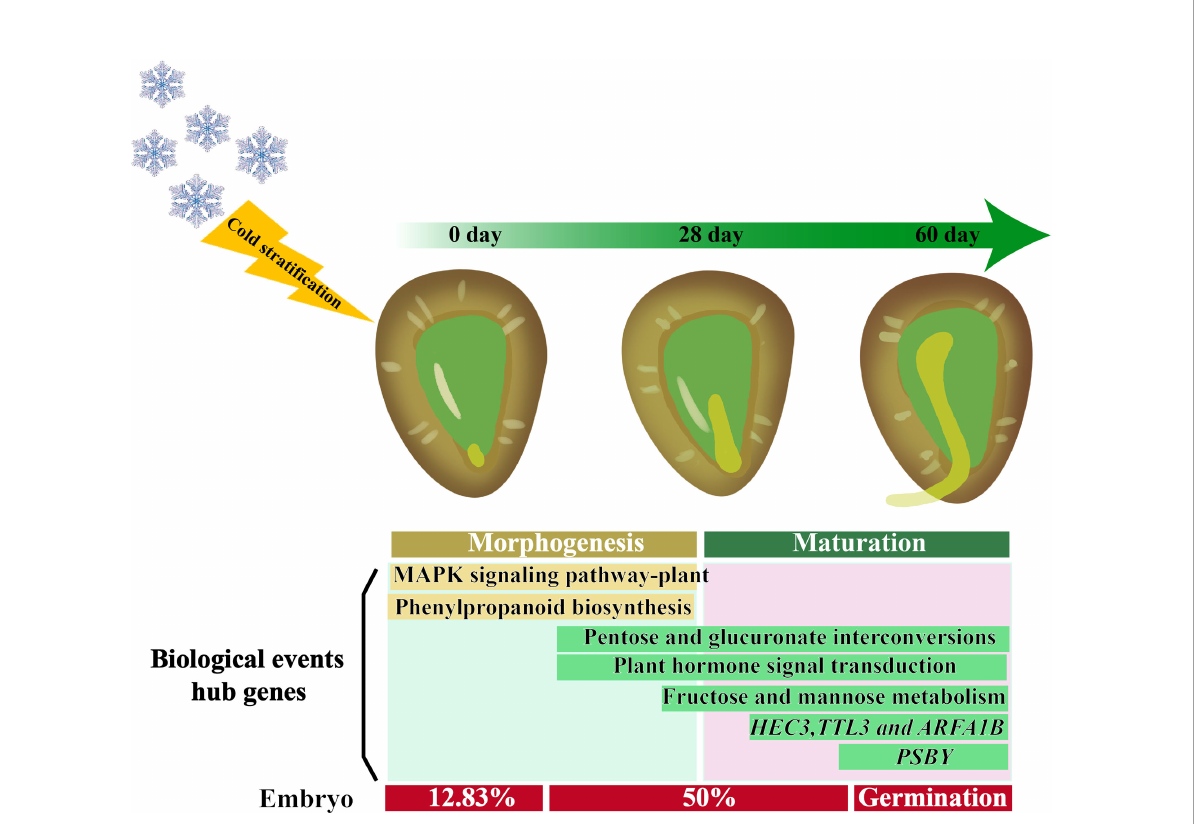
FIGURE 8 Proposed model of dormancy-breaking of F. taipaiensis seeds by cold strati fi cation. The dormancy breaking process of F. taipaiensis seeds is de fi ned as: When seeds ‘ sensed ’ cold stimulus, the pathways “ MAPK signaling pathway of plant ” and “ Phenylpropanoid biosynthesis ” in the seeds are quickly responded, and the pathways such as “ Pentose and glucuronate interconversions ” , “ Plant hormone signal transduction ” and “ Fructose and mannose metabolism ” are activated successively and throughout the process of dormancy breaking. Besides, the hub genes HEC3 , TTL3 , ARFA1B and PSBY seems to play an important role in the seed germination